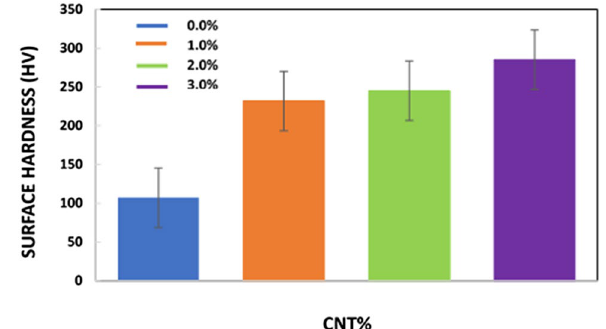
Figure 7. Microhardness of S0, S1.0, S2.0, and S3.0